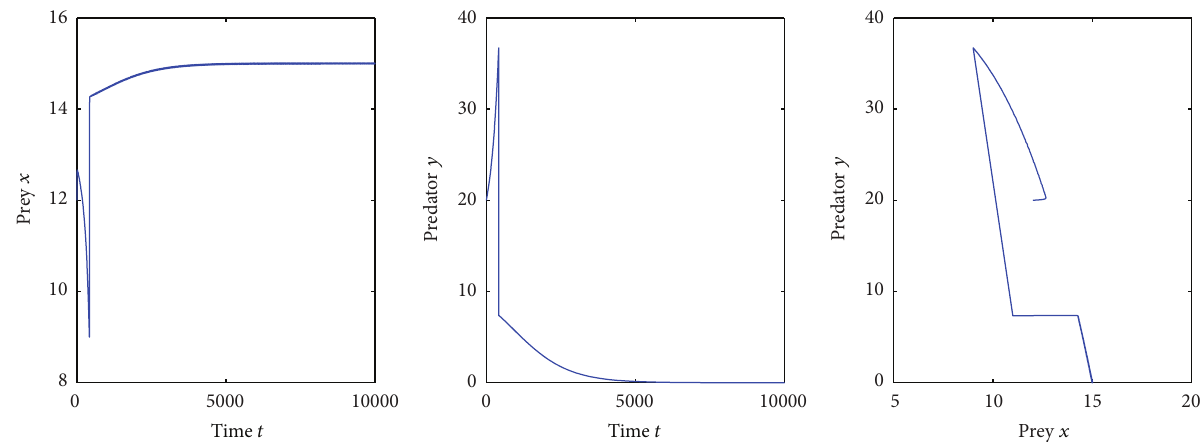
Figure 11: Time series and portrait phase of the system (2) when 𝑟 = 0.5 , 𝐾 = 15 , 𝑎 = 100 , 𝜇 = 0.8 , 𝐷 = 0.038 , ℎ = 9 , 𝜏 = 2 , 𝛽 = 0.8 , and (𝑥(0),𝑦(0)) = (12, 20)